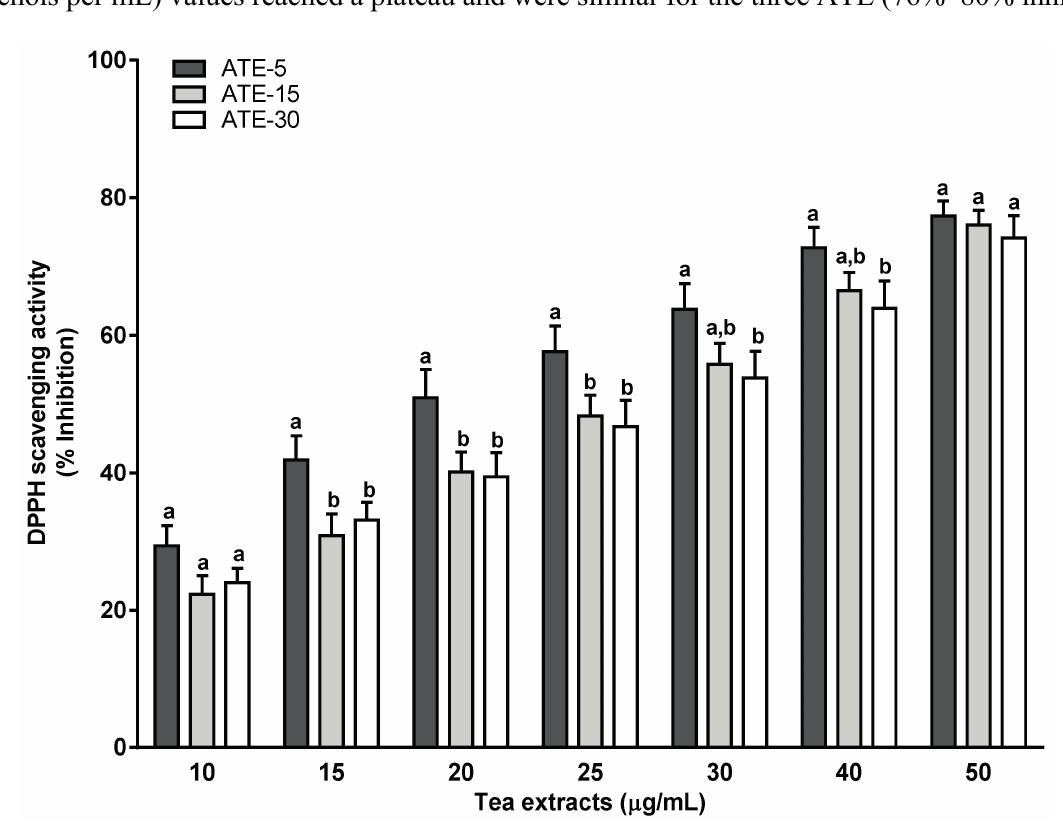
Figure 2. Antioxidant activity of tea extracts ATE-5, ATE-15 and ATE-30 using